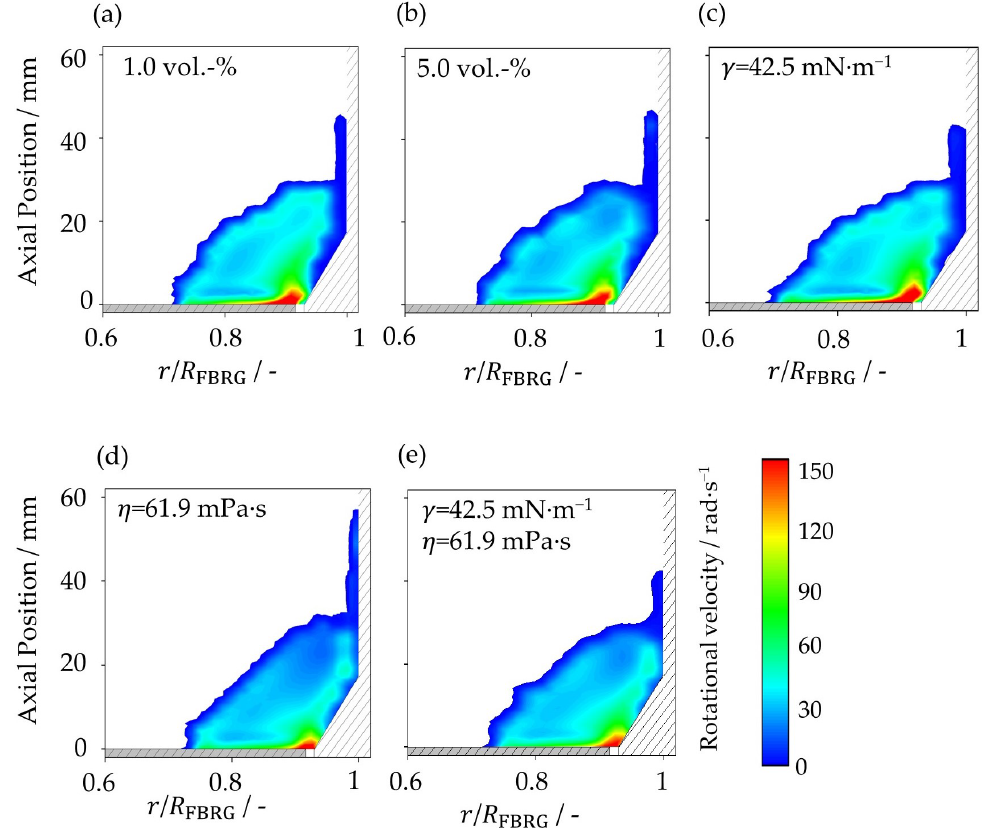
Figure 7. Poloidal distribution of rotational particle velocity at ( a ) liquid loading of 1 vol.-%, ( b ) liquid loading of 5 vol.-%, ( c ) surface tension of 42.5 mN∙m −1 , ( d ) viscosity of 61.9 mPa∙s, and ( e ) surface tension of 42.5 mN∙m −1 and viscosity of 61.9 mPa∙s. Table 4. The particle rotation number and the radial movement proportion for the five simulation cases.